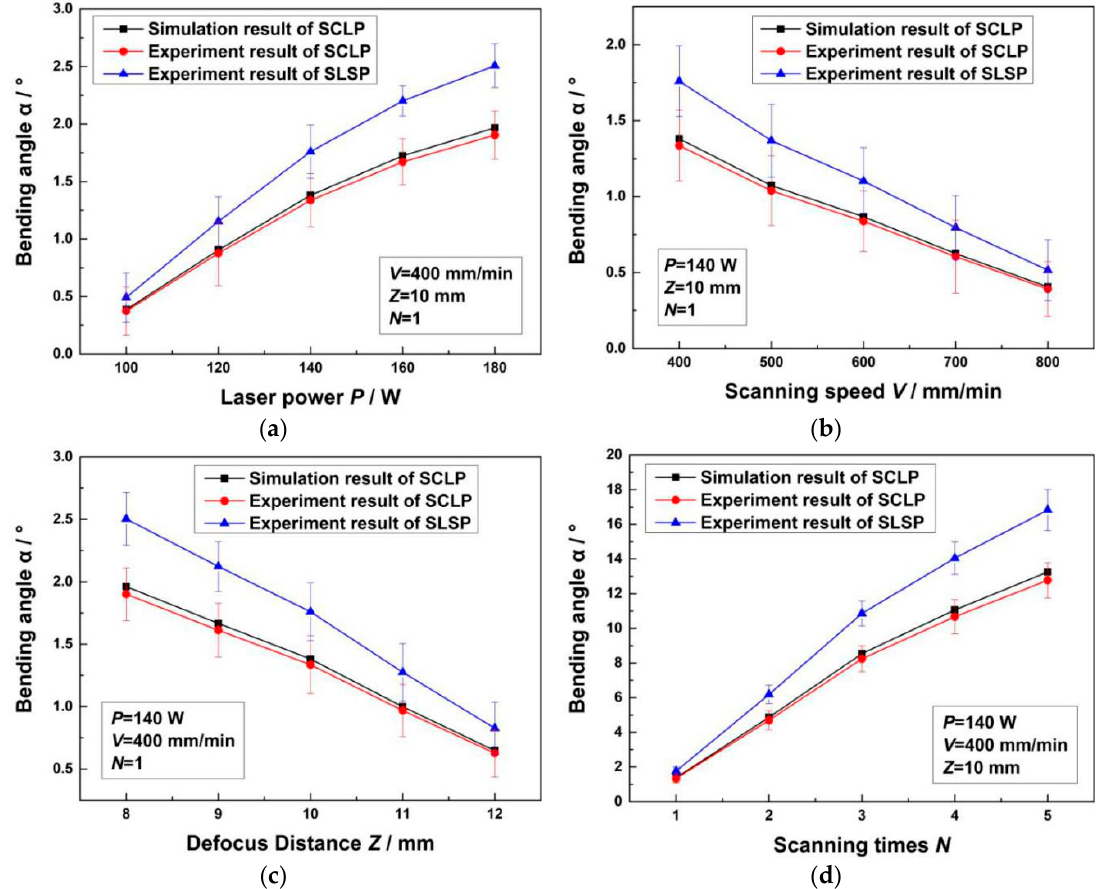
Figure 14. Comparison of bending angle curves of the SCLP and the SLSP with different process parameters: ( a ) Laser power; ( b ) scanning speed; ( c ) defocus distance; ( d ) scanning time.